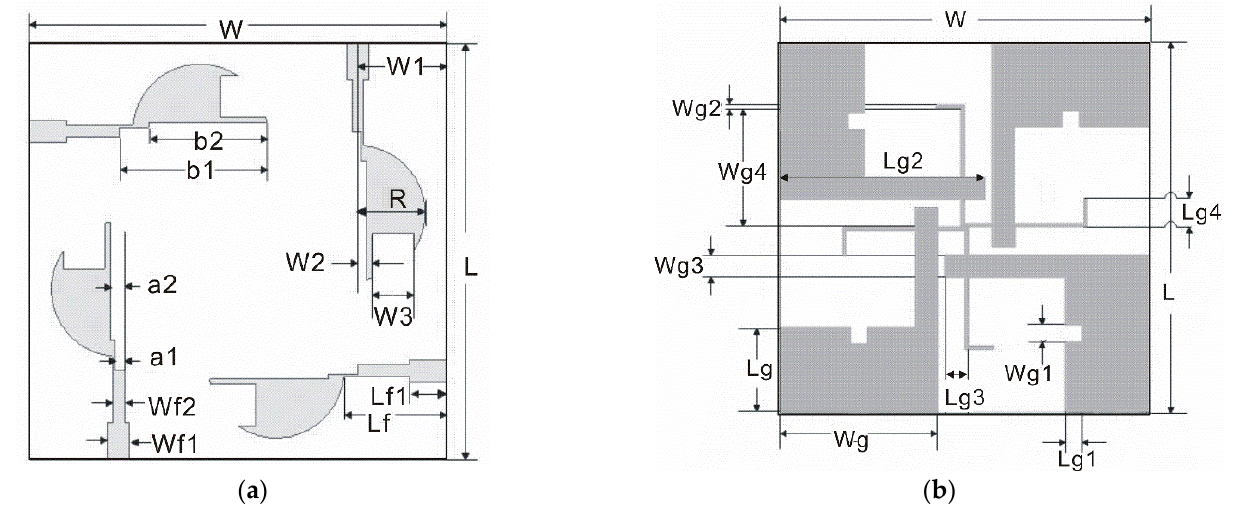
Figure 6. The schematic diagram of the proposed antenna: ( a ) top; ( b ) bottom. Table 1. Geometric parameters of the proposed MIMO antenna.